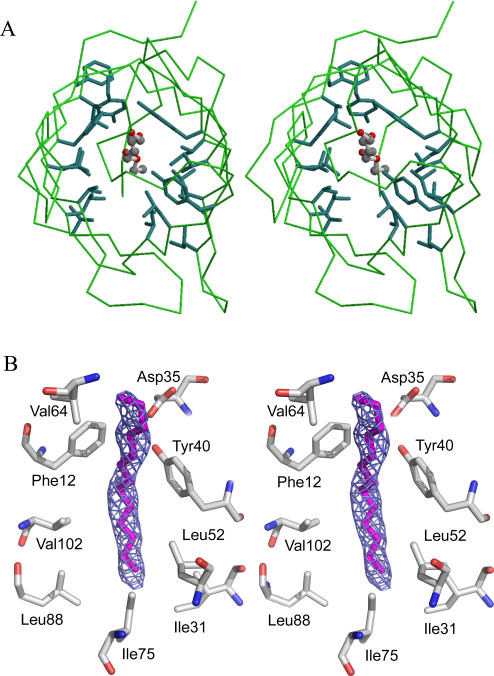
Stereo View of the β-Barrel and the Bound ligand(A) Stereo view of the Cα trace of GrlR β-barrel shown in green, viewed from the top. The hydrophobic side chains of the residues from the pore region are shown in thick lines. The ball-and-stick representation of the Triton-X100 molecule at the center of the pore is shown. This figure was prepared by using Molscript and Raster3D [42,43].(B) Simulated annealing Fo-Fc omit map in the pore region of GrlR. The bound triton molecule and all atoms within 2 Å of the triton molecule were omitted prior to refinement. The map contoured at a level of 3σ. This figure was prepared using PyMOL [44].